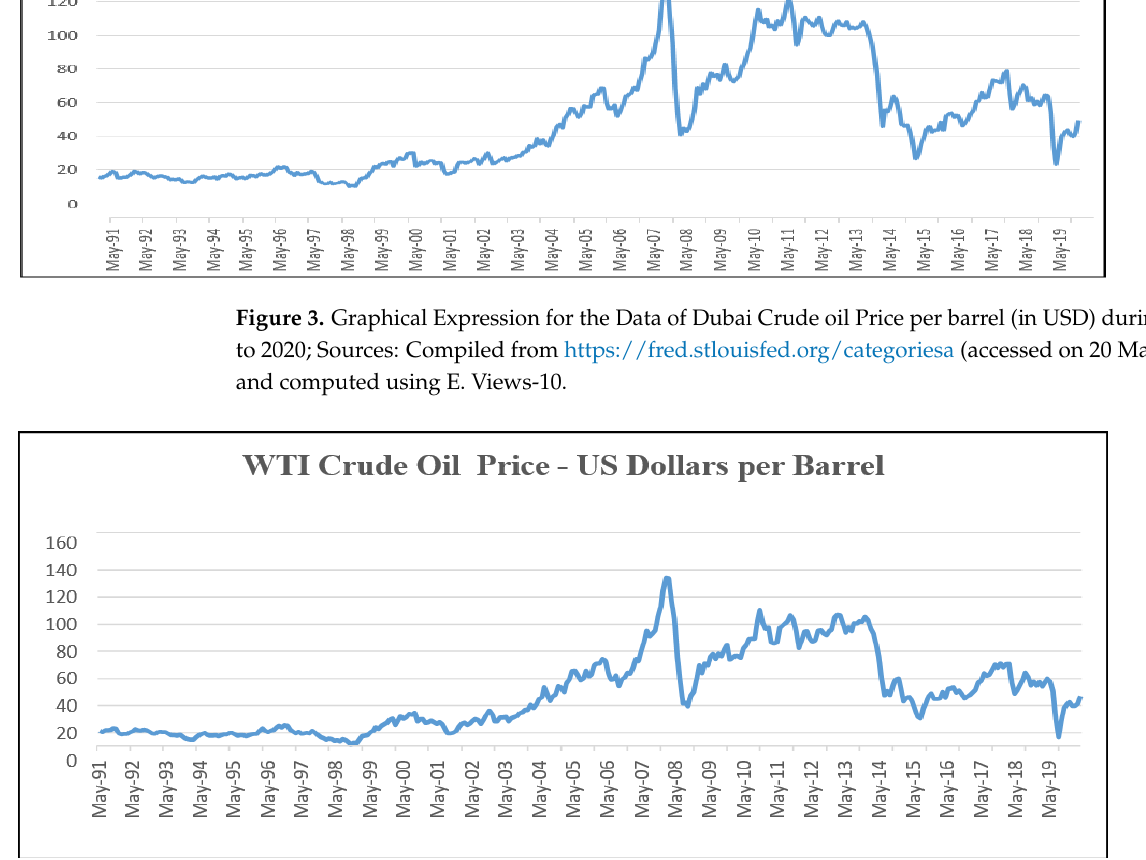
Figure 4. Graphical expression for the Data of WTI Crude Oil Price per barrel (in USD) during 1990 to 2020; Sources: Compiled from https://fred.stlouisfed.org/categoriesa and computed using E. Views-10.